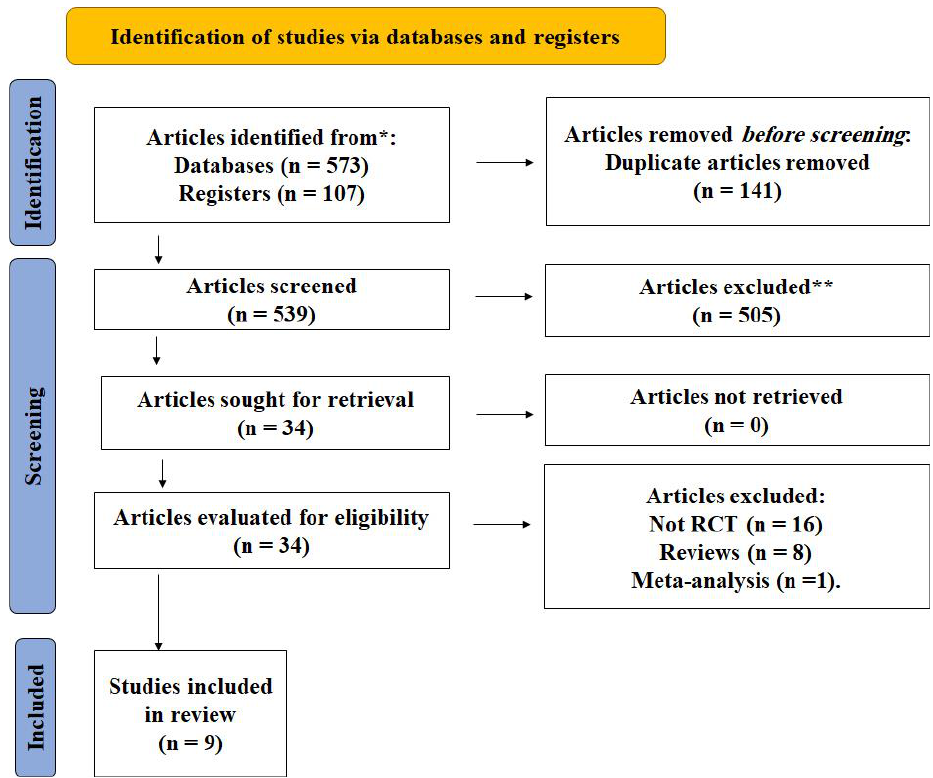
Figure 1. PRISMA flow diagram. * According to the inclusion criteria of articles in the study. ** The articles were excluded according to the exclusion criteria described in the methods Table 1. Characteristics of included studies considered in this study.